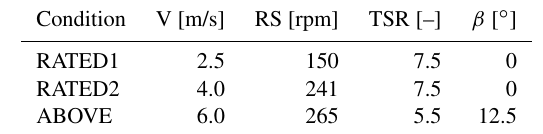
Table 1. Tested wind turbine operating conditions ( V is average wind speed, RS is rotor speed, and β is blade pitch angle).